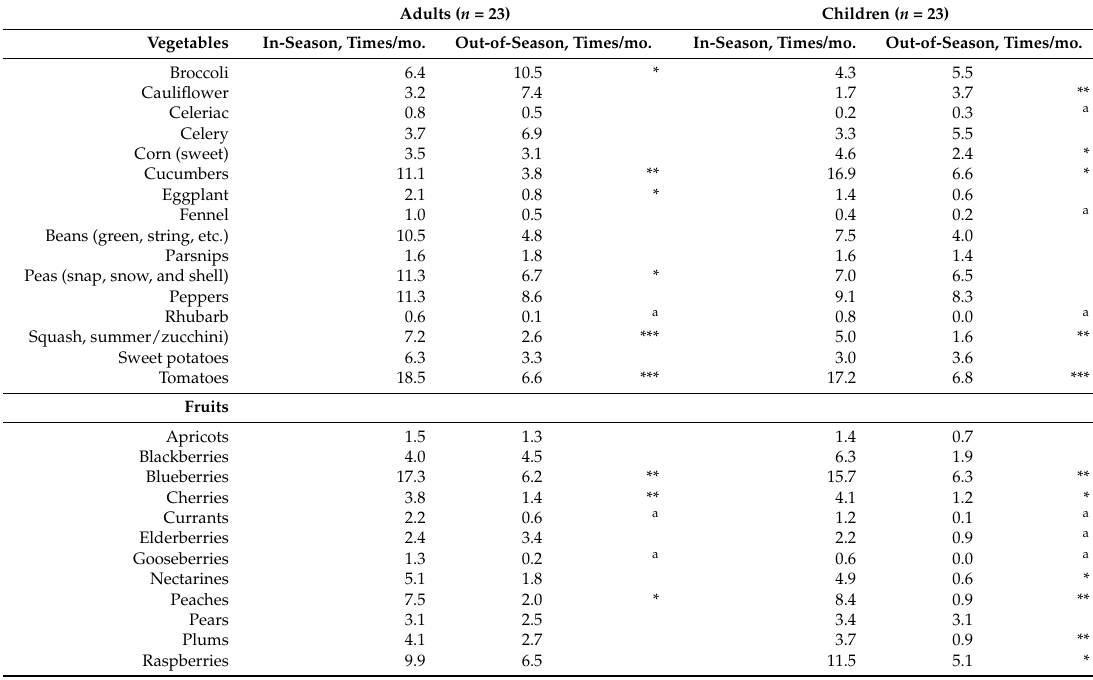
Table 3. Mean frequency of consumption of vegetables and fruits in a cohort of 41 low-income households that participated in cost-offset community supported agriculture (CO-CSA), by whether locally in-season or out-of-season. Adults ( n = 23) Children ( n = 23) Vegetables In-Season, Times/mo. Out-of-Season, Times/mo. In-Season, Times/mo. Out-of-Season, Times/mo. Broccoli